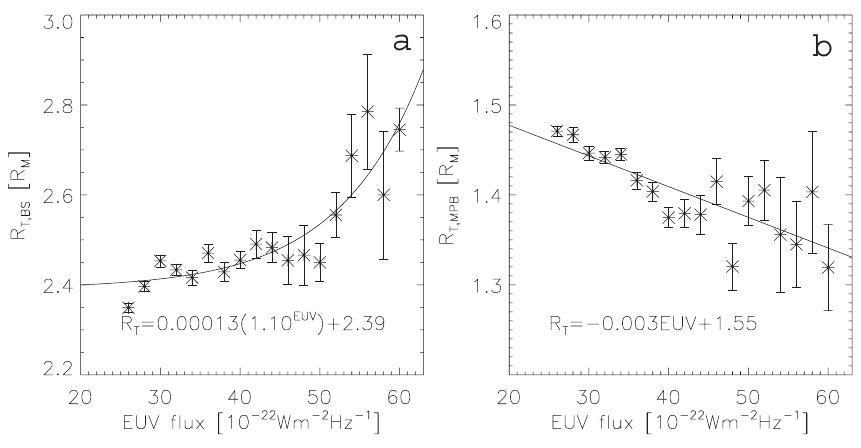
Fig. 10. Extrapolated terminator distance of the (a) BS and (b) MPB crossings observed by MEX from February 2004 until January 2009 plotted as a function of solar EUV flux proxy. The solid lines are fitted curves to the data points and the error bars show standard error on the mean